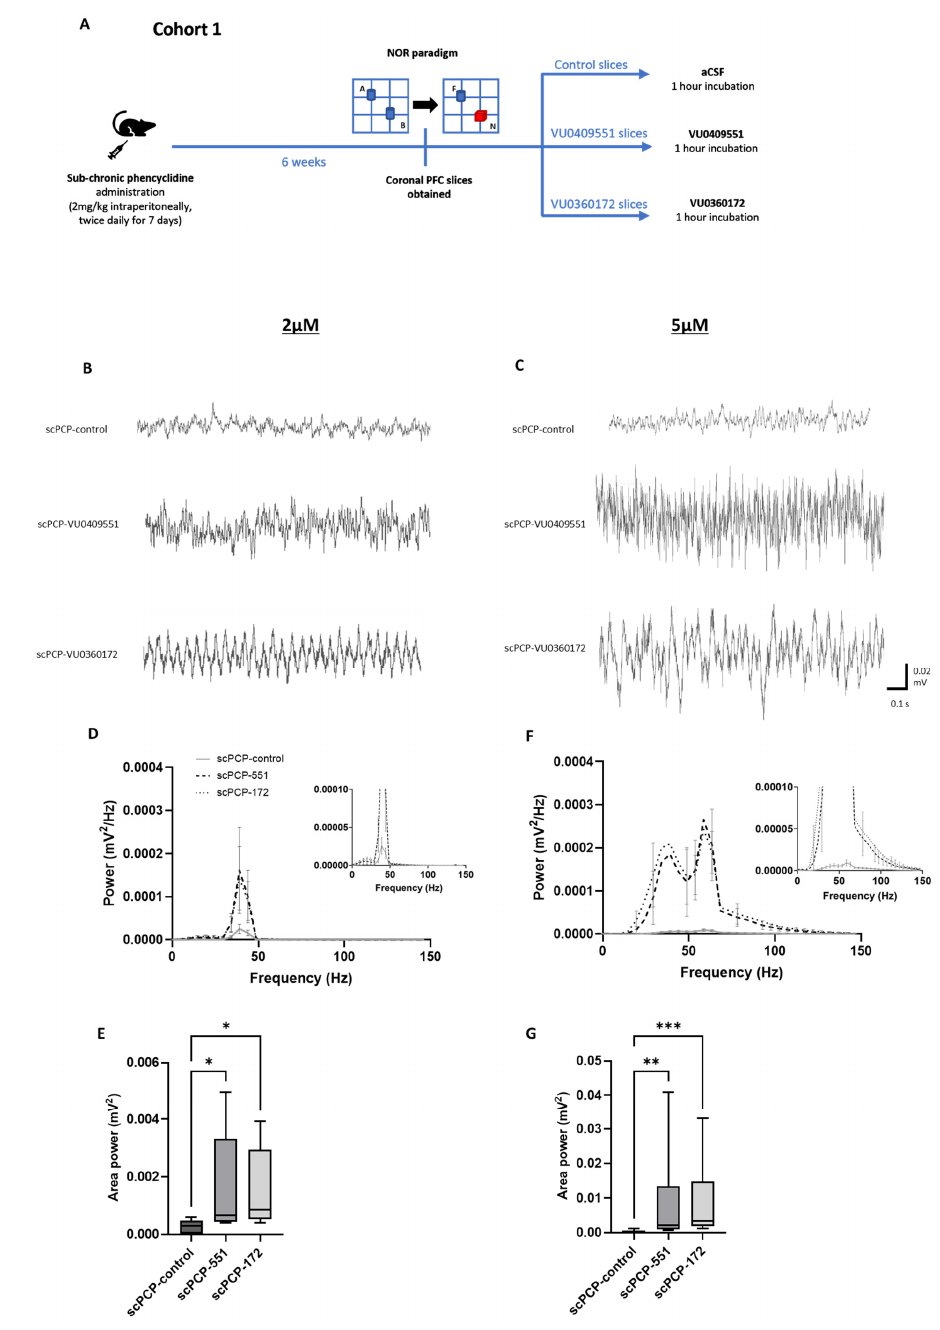
Figure 4. Incubation of scPCP slices with either VU0409551 or VU0360172 significantly increased gamma oscillatory power. ( A ) Schematic illustrating the experimental protocol for Cohort 1. A, B, blue; identical objects. F, blue; familiar object. N, red; novel object. ( B , C ) Representative traces showing oscillatory activity in PFC slices from scPCP-treated rats without PAM application (scPCP- control), and scPCP slices treated with VU0409551 or VU0360172. Power spectrum analyses show the effect of VU0409551 or VU0360172 incubation at ( D ), 2 µ M ( n = 5 per group, analysed using a Friedman’s test followed by Dunn’s tests) and ( F ), 5 µ M ( n = 10 per group, analysed using a 2-way ANOVA) on amplitude power. Graph insets more clearly illustrate data in low power ranges. Box plots show the median (whiskers max–min) area power in slices incubated in VU0409551 or VU0360172 at ( E ), 2 µ M ( n = 5 per group) and ( G ), 5 µ M ( n = 10 per group; both analysed using Friedman’s tests followed by Dunn’s tests; * p < 0.05, ** p < 0.01, *** p < 0.001, significant increase in area power compared to scPCP-control